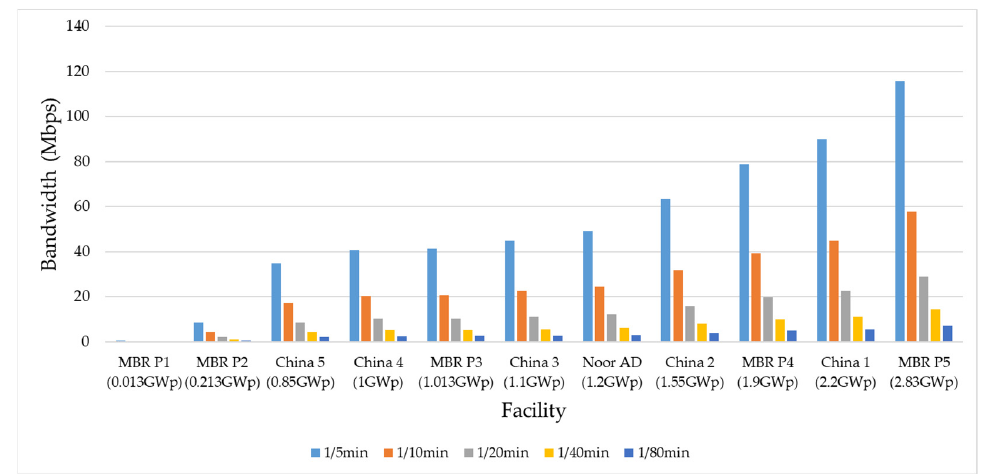
Figure 17. Bandwidth requirement by each facility for different reporting frequencies.